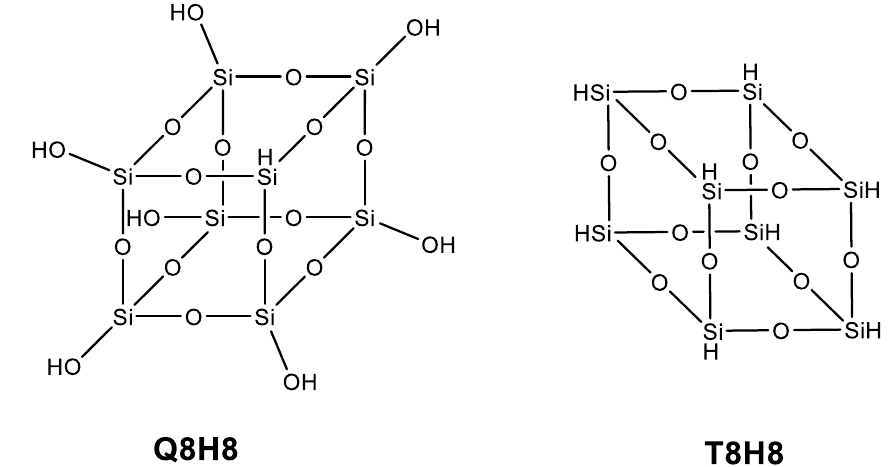
Figure 1. Silsesquioxane cages. The Si-H and Si-OH groups on the silsequioxanes suggested hydrosilylation would be an ideal bond forming reaction between the cages and the complexes and, therefore, the ideal linking functional group on the cyclen ligand would be an alkene. We set out to prepare a range of cyclen ligands that were trisubstituted through secondary carbon centres and contained a fourth arm added subsequently that contained the alkene